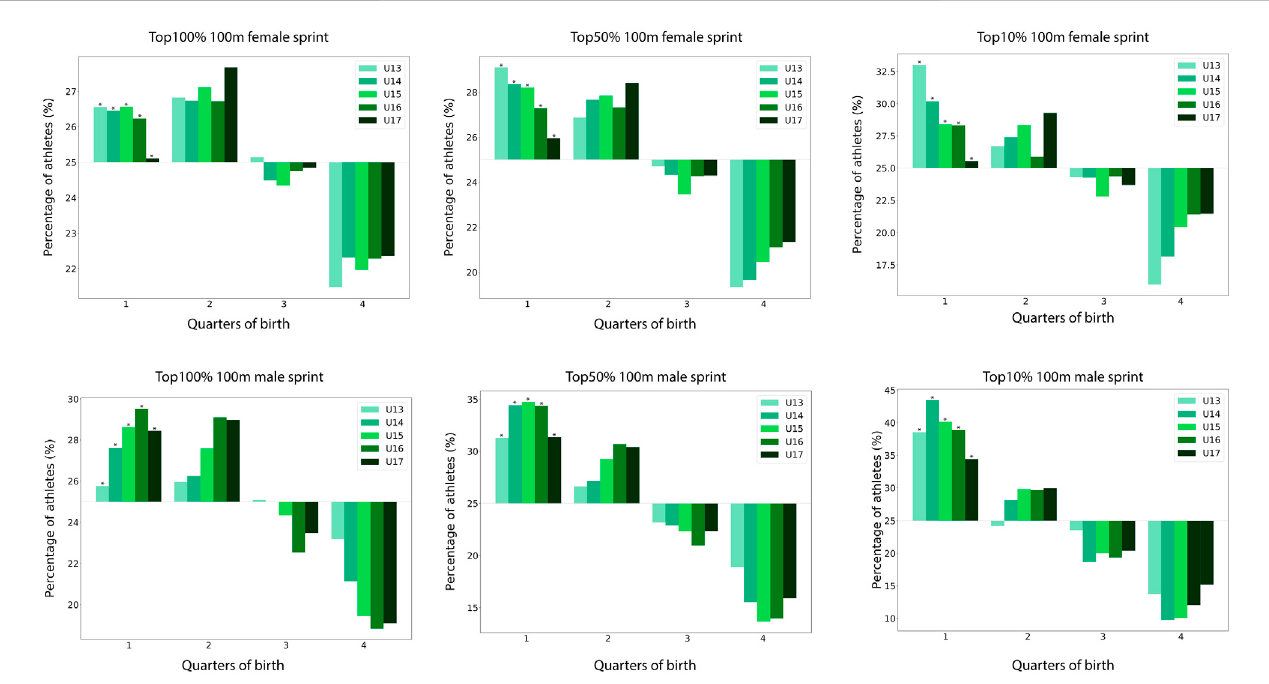
FIGURE 1 Birth quarters distribution according to age categories and performance level for female and male 100 m sprint. *: p < .01.